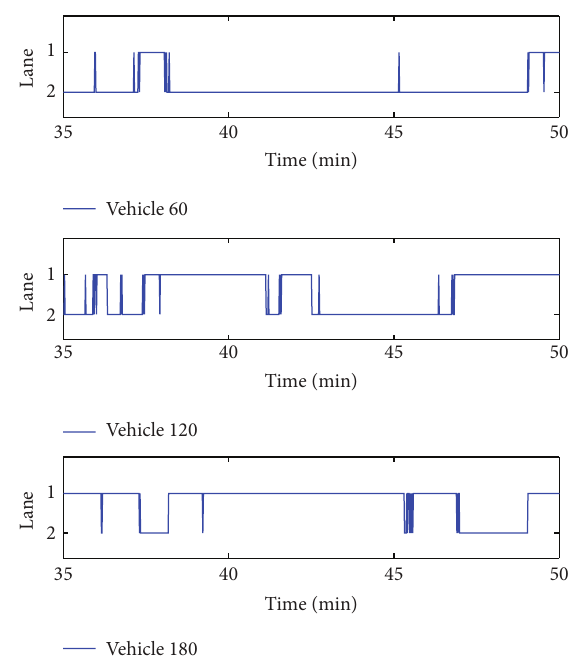
Figure 4: Three vehicles numbered 60, 120, and 180 changing lanes from lane 1 to lane 2 or vice versa between a time window of 35 min to 50